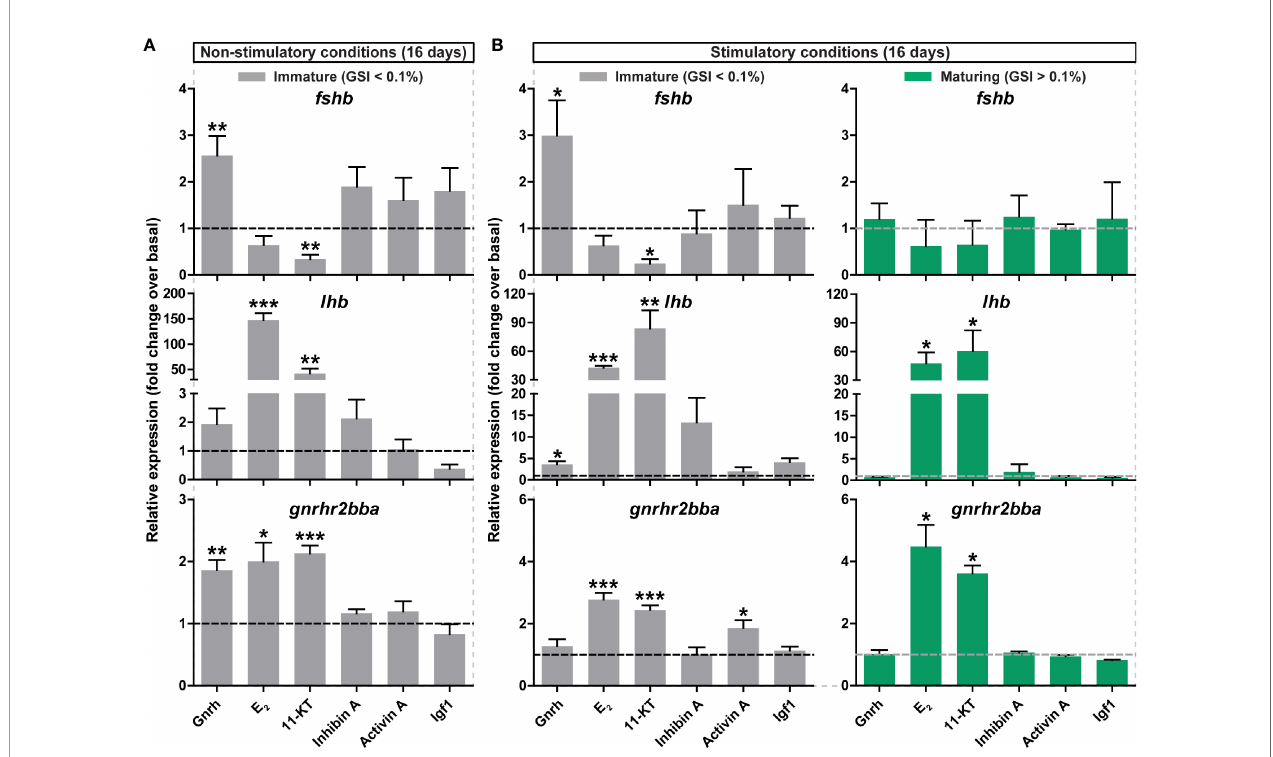
FIGURE 5 | Ex vivo effects of potential regulators on selected pituitary genes. (A, B) Expression levels of fshb , lhb and gnrhr2bba in pituitaries collected from immature postsmolt males exposed to non-stimulatory conditions [12 hours dark/12 hours light, and 16°C; (A) ] and immature and maturing postsmolt males exposed to stimulatory conditions [constant light and 16°C; (B) ] for 16 days, and subsequently incubated ex vivo for 9 days in the presence of various potential regulators of pituitary gene expression. Results are shown as mean fold change ± SEM (N = 3-6; *p < 0.05; **p < 0.01; ***p < 0.001) and expressed relative to the control basal condition, which is set at 1 (dashed